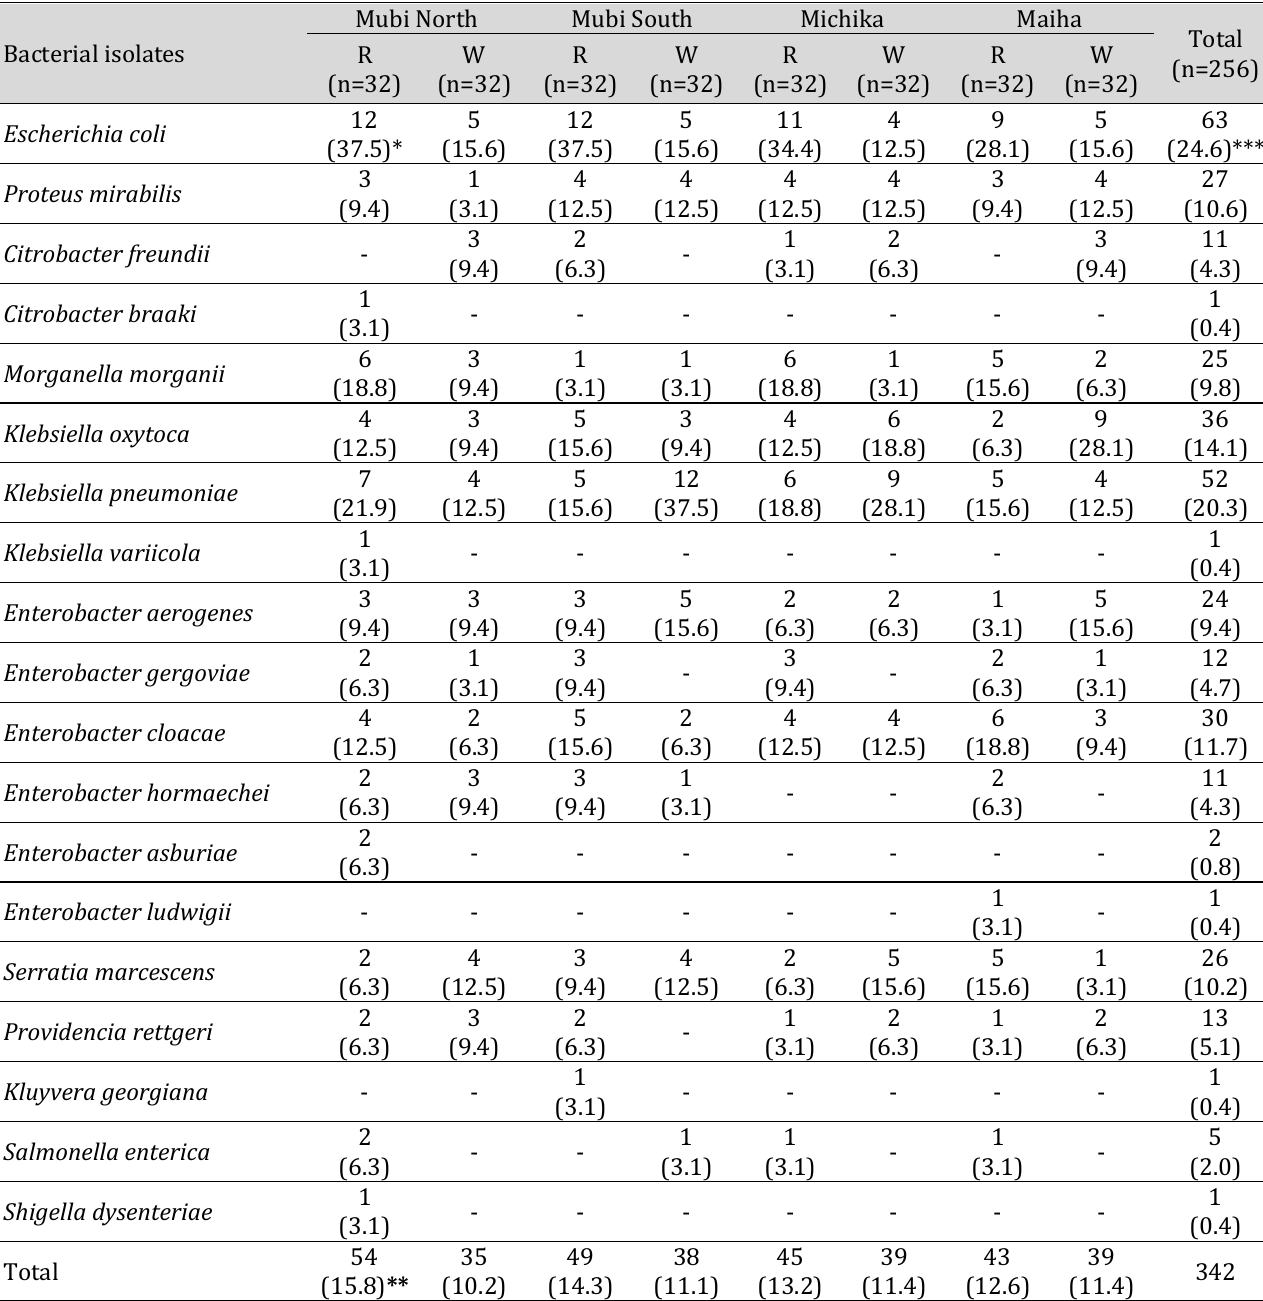
Table 1. Prevalence of Enterobacteriaceae species from water sources in Adamawa-North senatorial zone